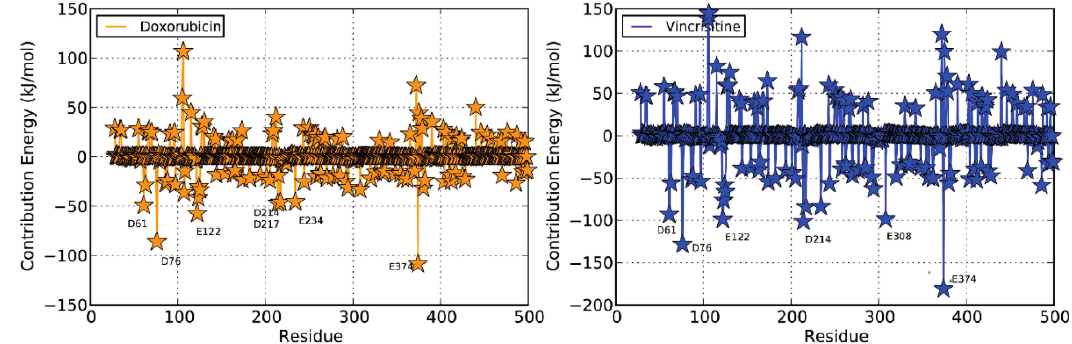
Figure 6. Per-residue free energy decomposition for the simulated complexes of cytarabine ( green ), daunorubicin ( red ), doxorubicin ( yellow ) and vincristine ( blue ). The most favorable interacting residues are